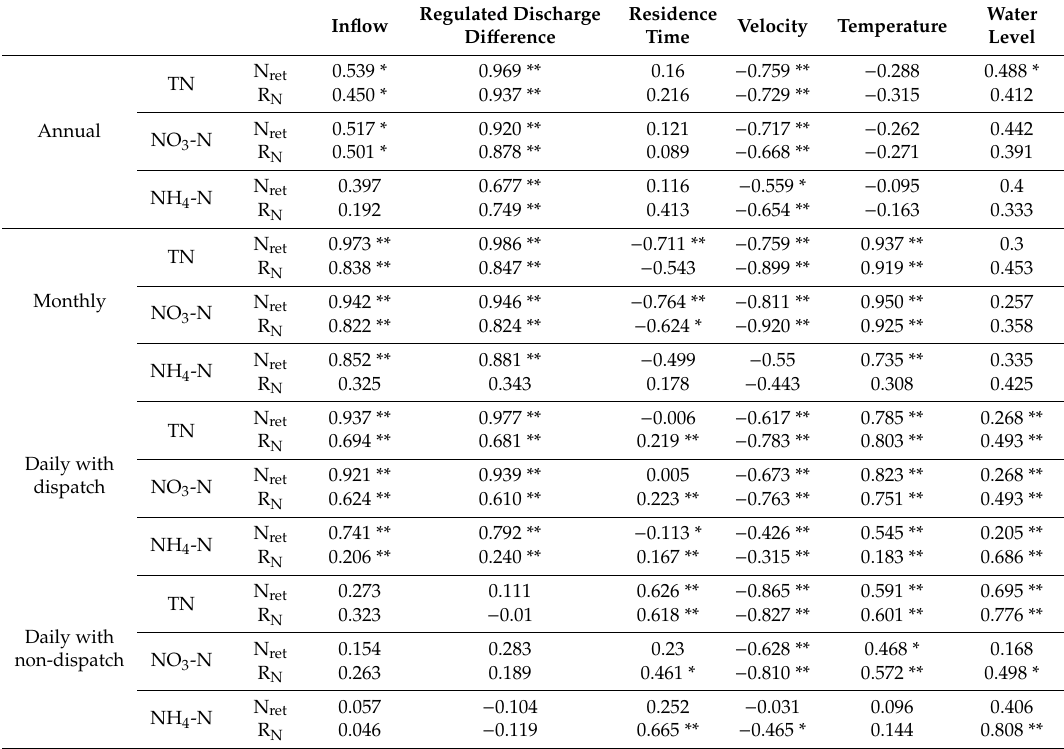
Table 2. Correlations between influential factors and nitrogen retention at annual, monthly and daily